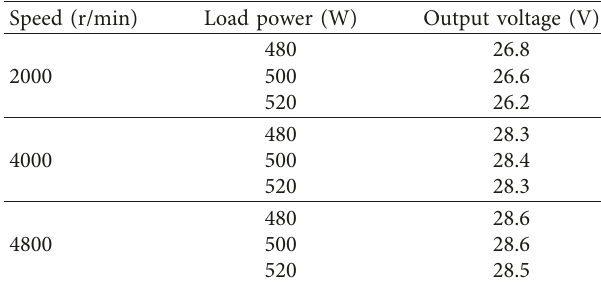
Figure 14: Comparison experimental results of no-load back-EMF waveforms. (a) No-load back-EMF waveforms before optimization. (b) No-load back-EMF waveforms after optimization. Table 6: Test results of the generator output